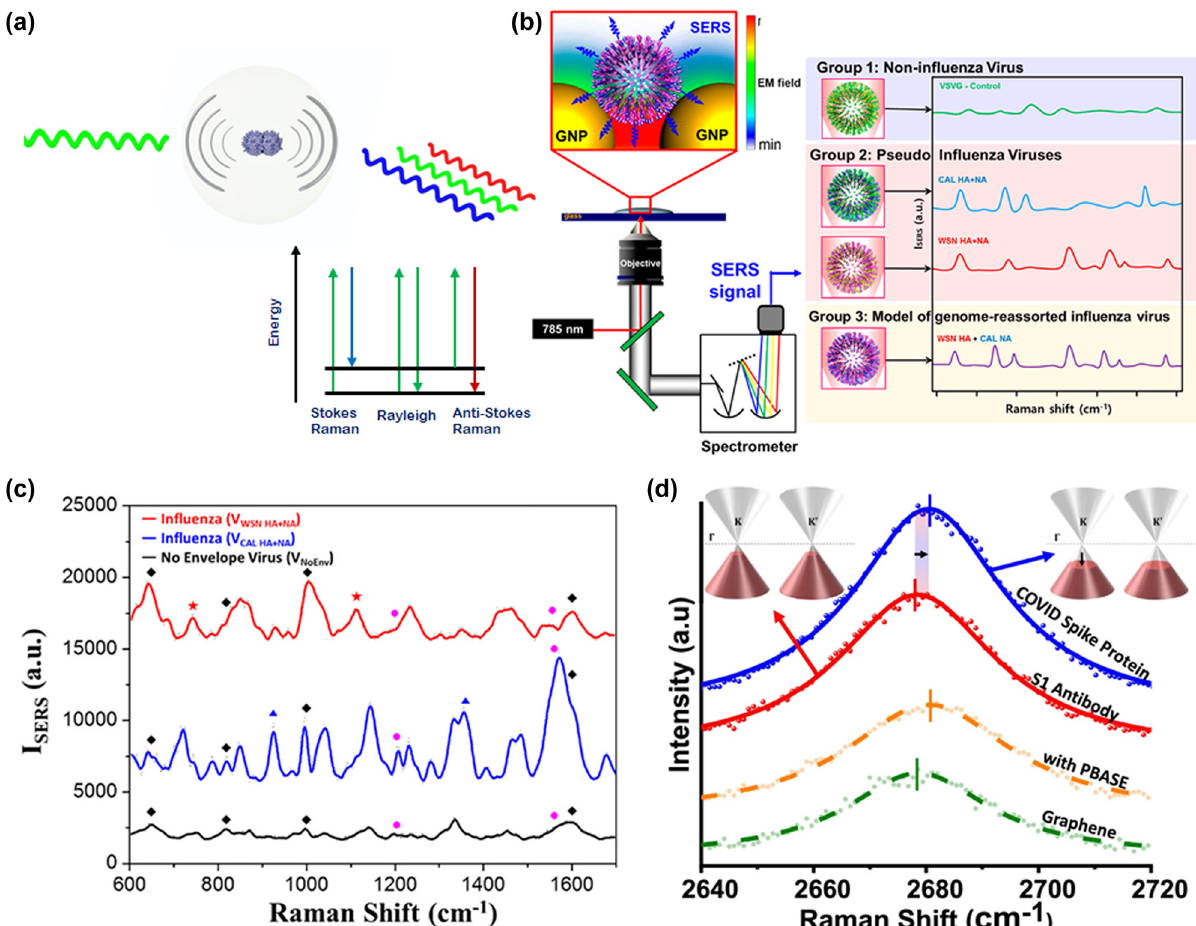
Figure 3: Illustration of the Surface Enhanced Raman Scattering (SERS) technique for virus detection. (a) Concept of detecting virus using Raman scattering due to the molecular vibrations. (b) Schematic diagram representing the identification of viruses by Surface Enhanced Raman Scattering (SERS) method. Adapted with permission from ref. [49] Copyright [2015] American Chemical Society. (c) Raman spectra of (a newly emerging influenza virus strain) and V (a lab adapted influenza virus strain). Adapted with permission from V CALHA + NA WSNHA + NA